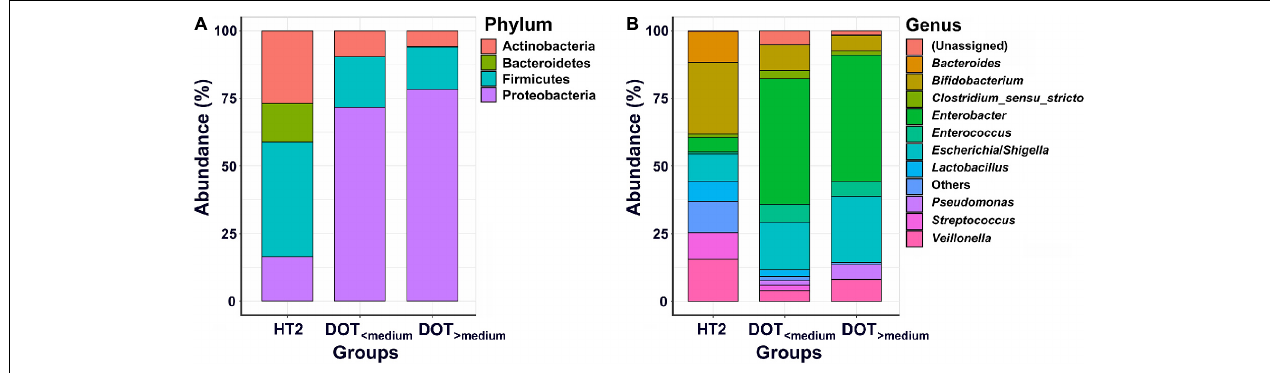
FIGURE 5 | Abundances of bacterial taxa between preterm infants with different antibiotic exposure level. Mean relative abundances of bacterial taxa at phylum (A) and genus (B) levels in each group of the stool collections. HT2, healthy term infants at 4 weeks of age; DOT < median , preterm infants with DOT lower than median; DOT > median , preterm infants with DOT higher than median.